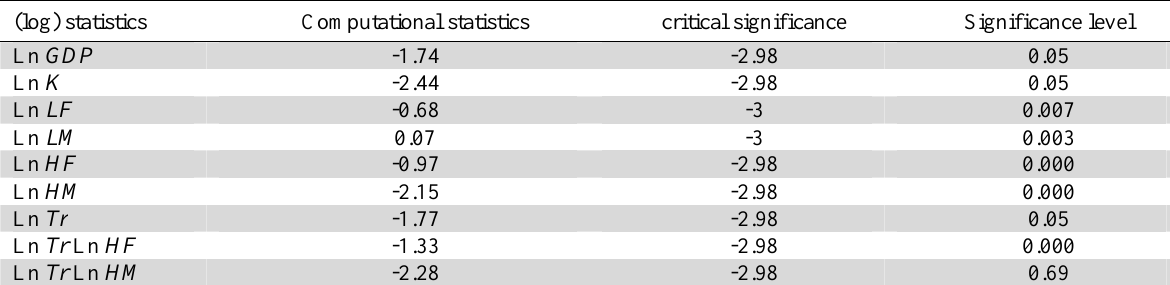
Unit Root Tests for Models